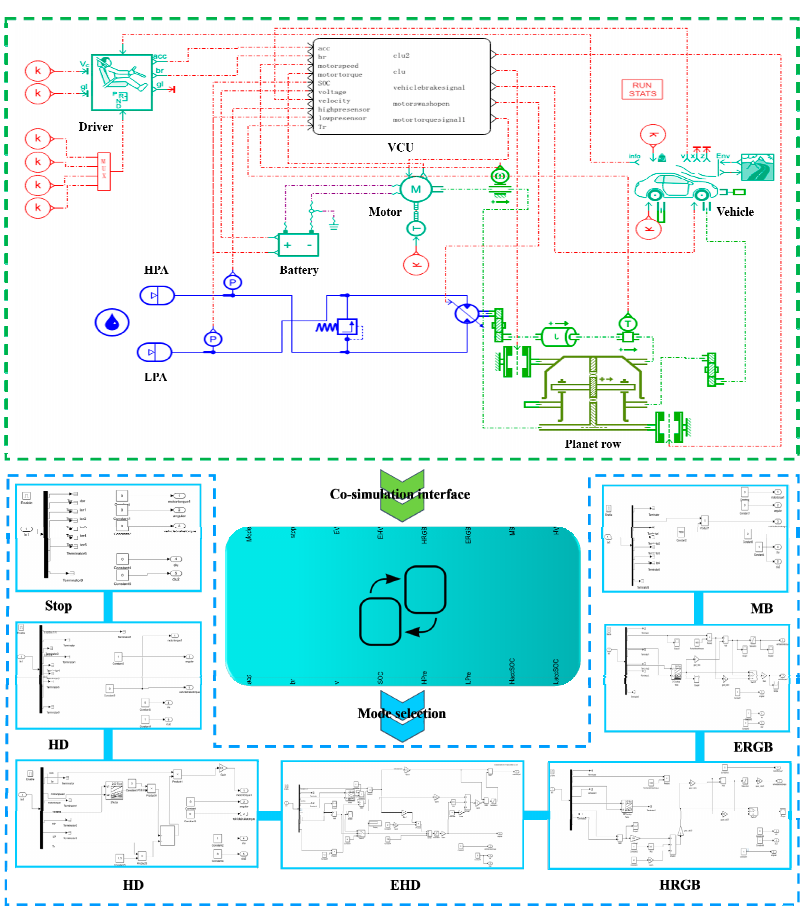
Figure 5. The MSEH-HEV mode in AMEsim and Simulink. Table 4. Cycle parameters of the ECE + EUDC.